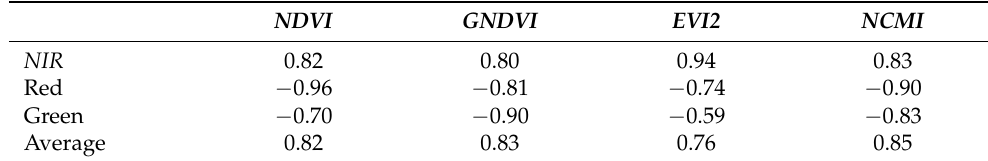
Table 3. Average of r between each band and VI by performing a linear regression for the avail- able dates (>41 DAS) on Sentinel-2 (the last row is the average of the r of every band in terms of absolute value). NDVI GNDVI EVI2 NCMI NIR 0.82 0.80 0.94 0.83 Red − 0.96 − 0.81 − 0.74 − 0.90 Green − 0.70 − 0.90 − 0.59 − 0.83 Average 0.82 0.83 0.76